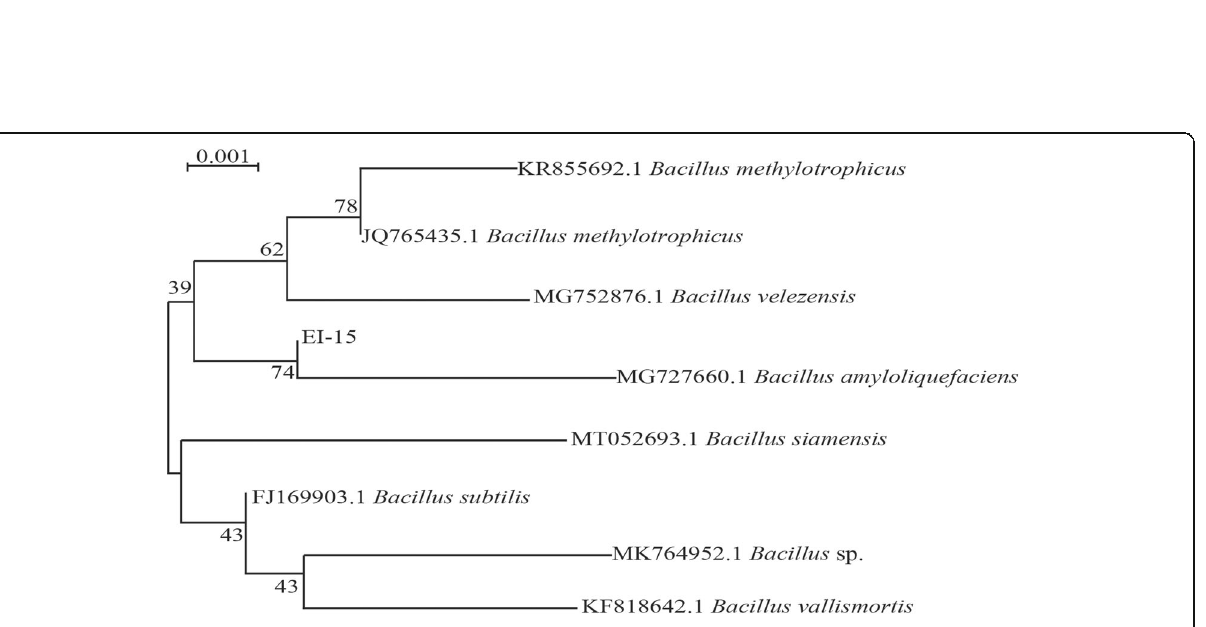
Fig. 2 A neighbor-joining tree shows the phylogenetic relationships among 16S rDNA sequences of EI-15 and their closely related sequences from NCBI. The scale bar indicates evolutionary